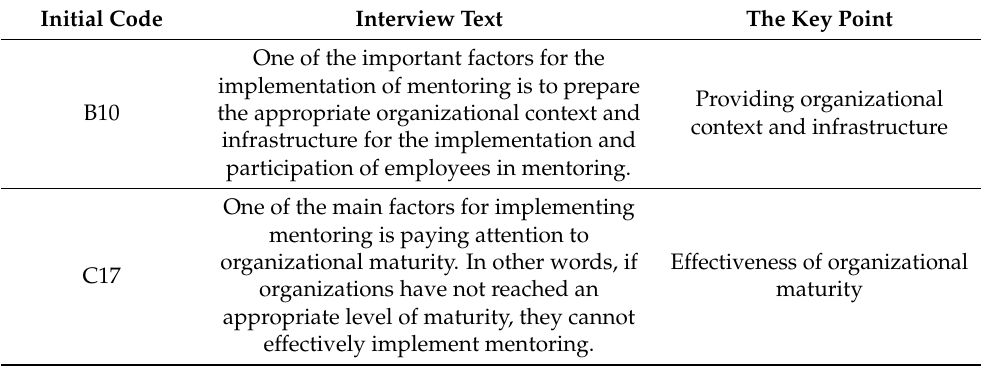
Table 2. Examples of initial